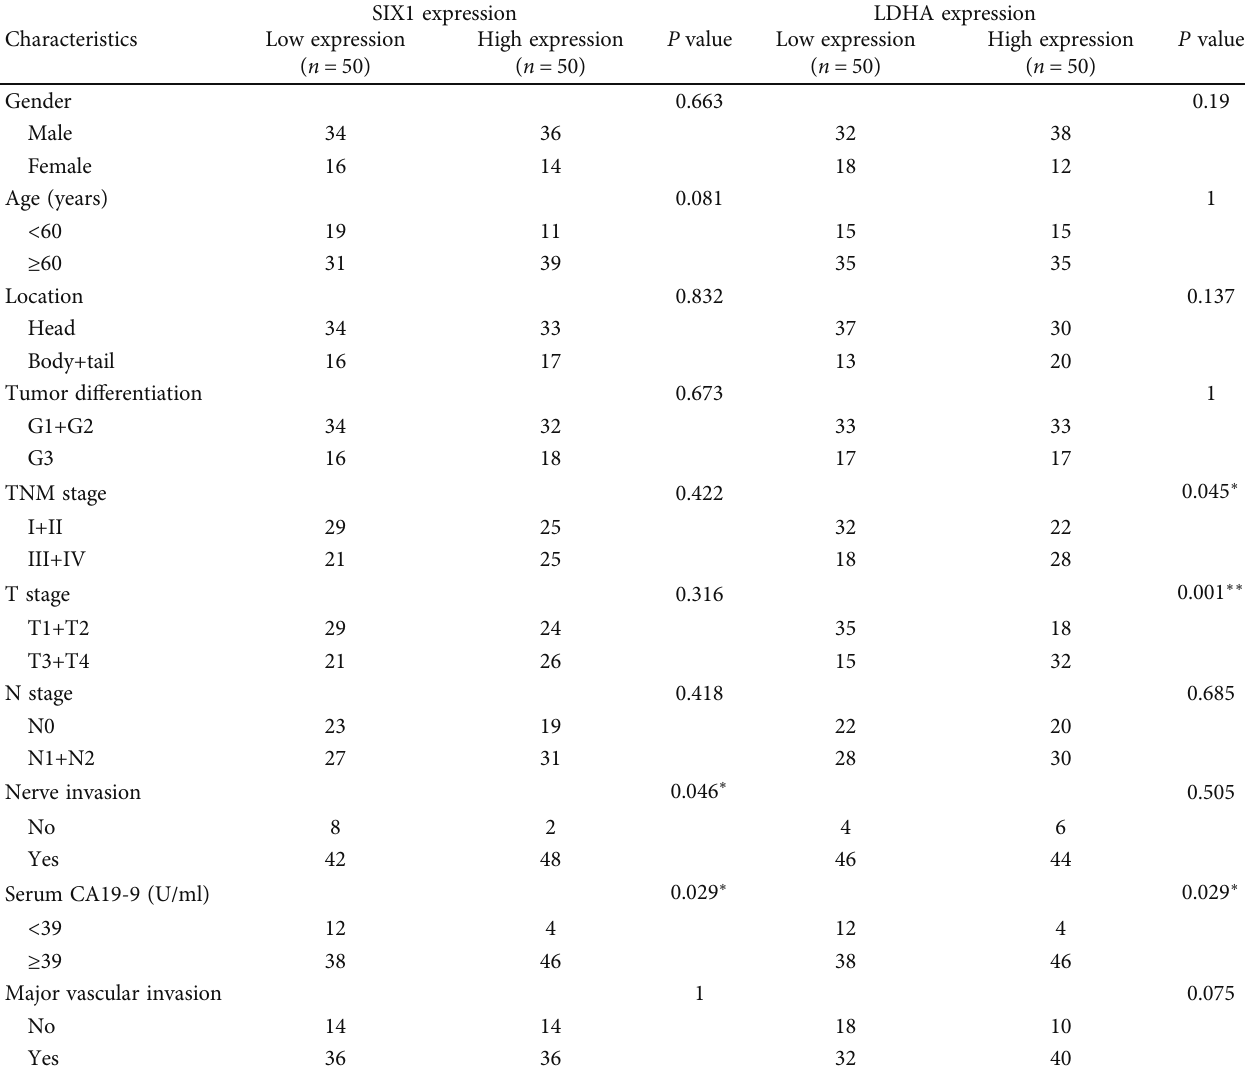
Table 1: Correlation between clinicopathological features and expression of SIX1 and